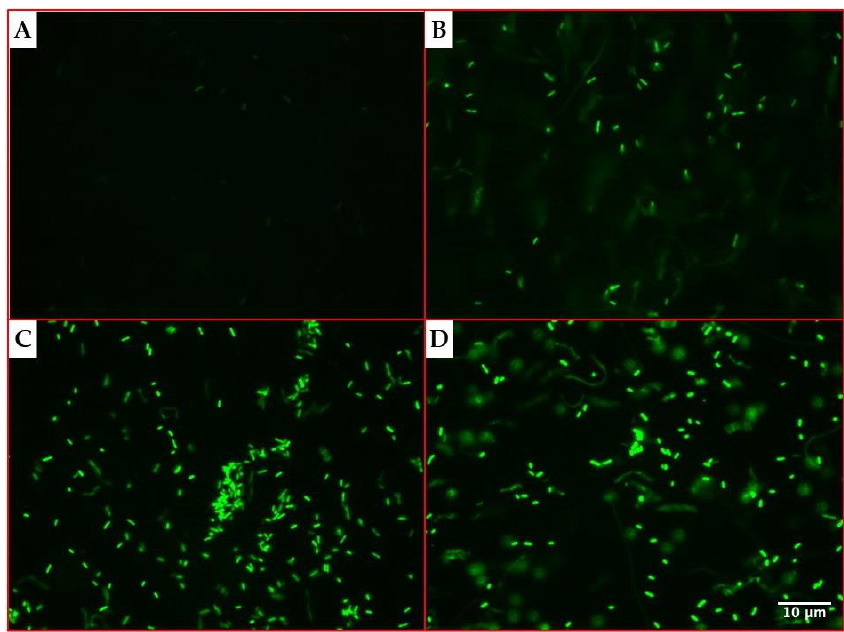
Figure 2. Green fluorescent protein production by P. aeruginosa PAEG1 detected by fluorescence microscopy. The production of the GFP(ASV) was assessed in a culture of the recombinant strain P. aeruginosa PAEG1 in LB broth supplemented with 0.2% arabinose, incubated for 0 ( A ), 1 ( B ), 2 ( C ) and 3 h ( D ) at 37 ◦ C. Aliquots of the culture were filtered in polycarbonate black filters (0.22 µ m diameter) and observed at 100 × magnification using a blue light